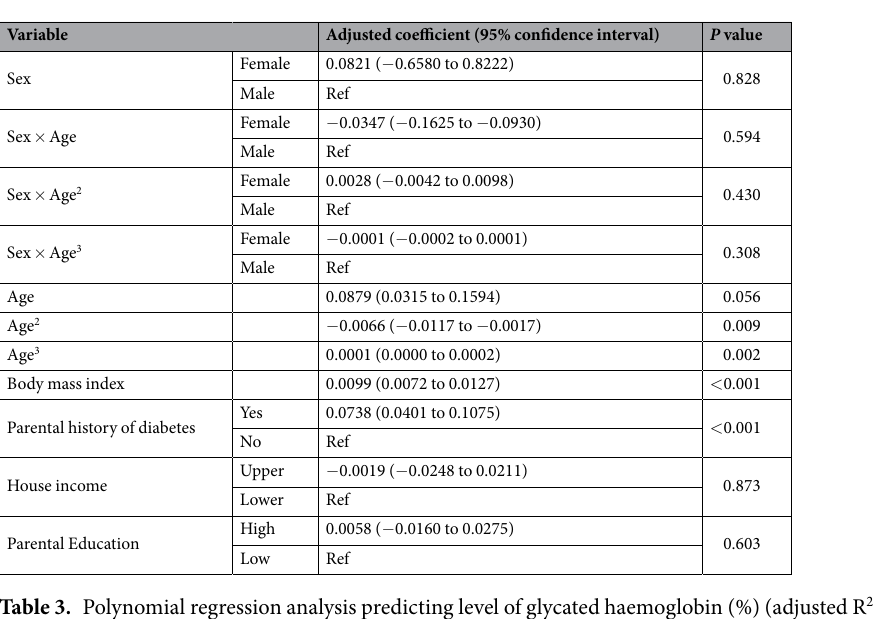
Table 3. Polynomial regression analysis predicting level of glycated haemoglobin (%) (adjusted R 2 = 0.056, P < 0.001). CI, confidence interval; Ref,